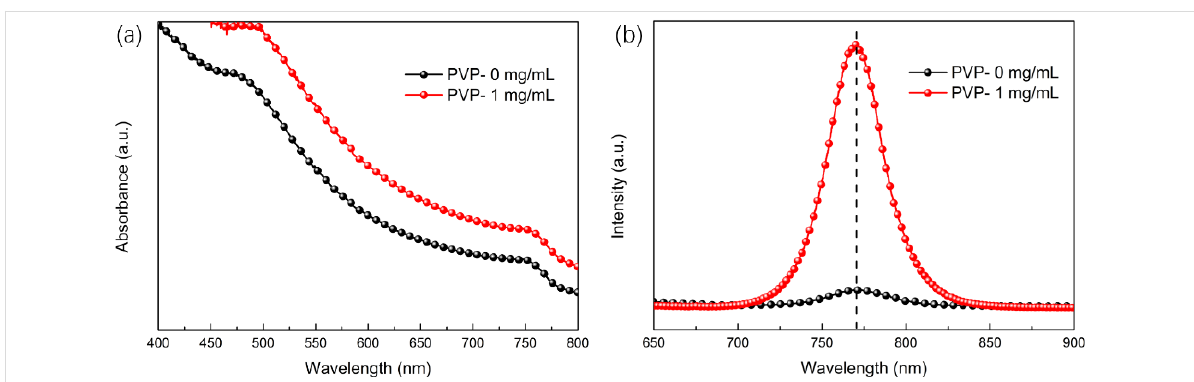
Figure 7: (a) UV–vis measurement of the film without PVP additive and the film with PVP additive of 1 mg/mL. (b) The steady-state photolumines- cence curves with an emission maximum at 760 nm were obtained upon excitation at 445